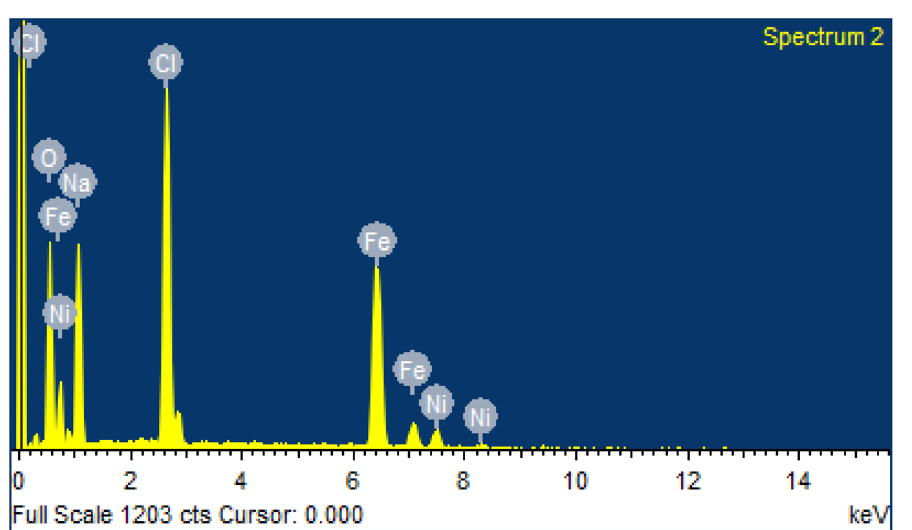
Figure 3. EDS—elemental composition of NiFe 2 O 4